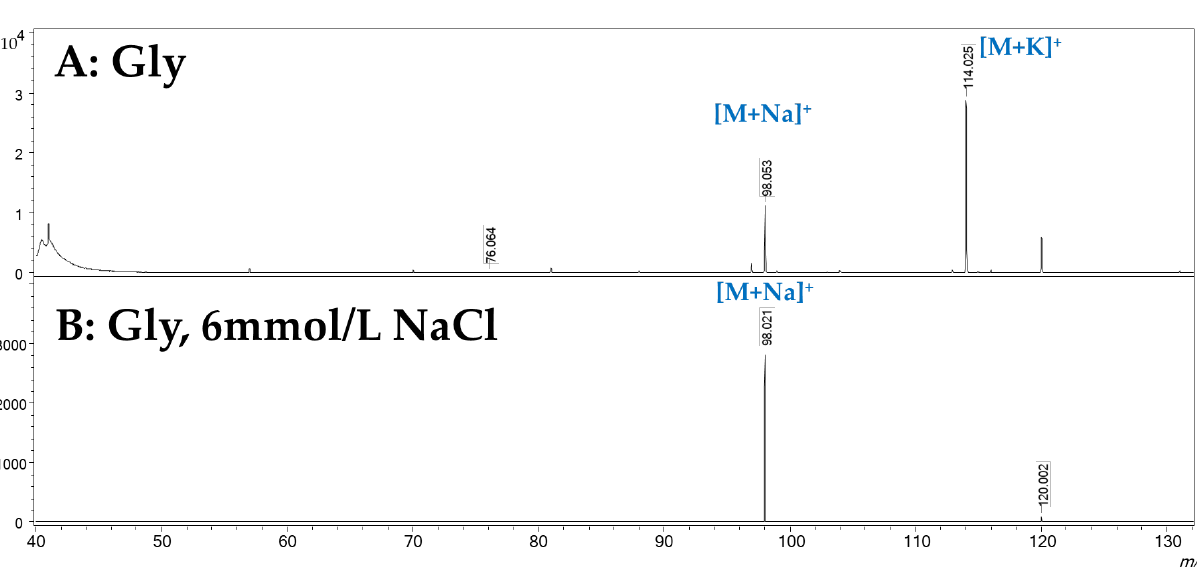
Figure 6. Panel ( A ): SALDI-MS spectrum, in positive ionization mode, of a water solution of glycine (1 mg/mL), obtained by treating SWCNHs with a 60 mmol/L solution of NaCl. Panel ( B ) : “Brilliant” structures on the SWCNH-based surface treated with a 60 mmol/L solution of NaCl captured by the instrumental camera. The SWCHN-based surface was also tested in negative ionization mode. Figure 7 re- ports the spectra obtained for the analysis of arginine and glutamine, where the [M − H] − species were clearly detectable in both cases, at m / z 173.235 and 146.123, respectively. An- yway, spectra obtained in negative mode showed a lower S/N ratio if compared to posi- tive ionization mode, and the presence of some other unidentified ionic species.